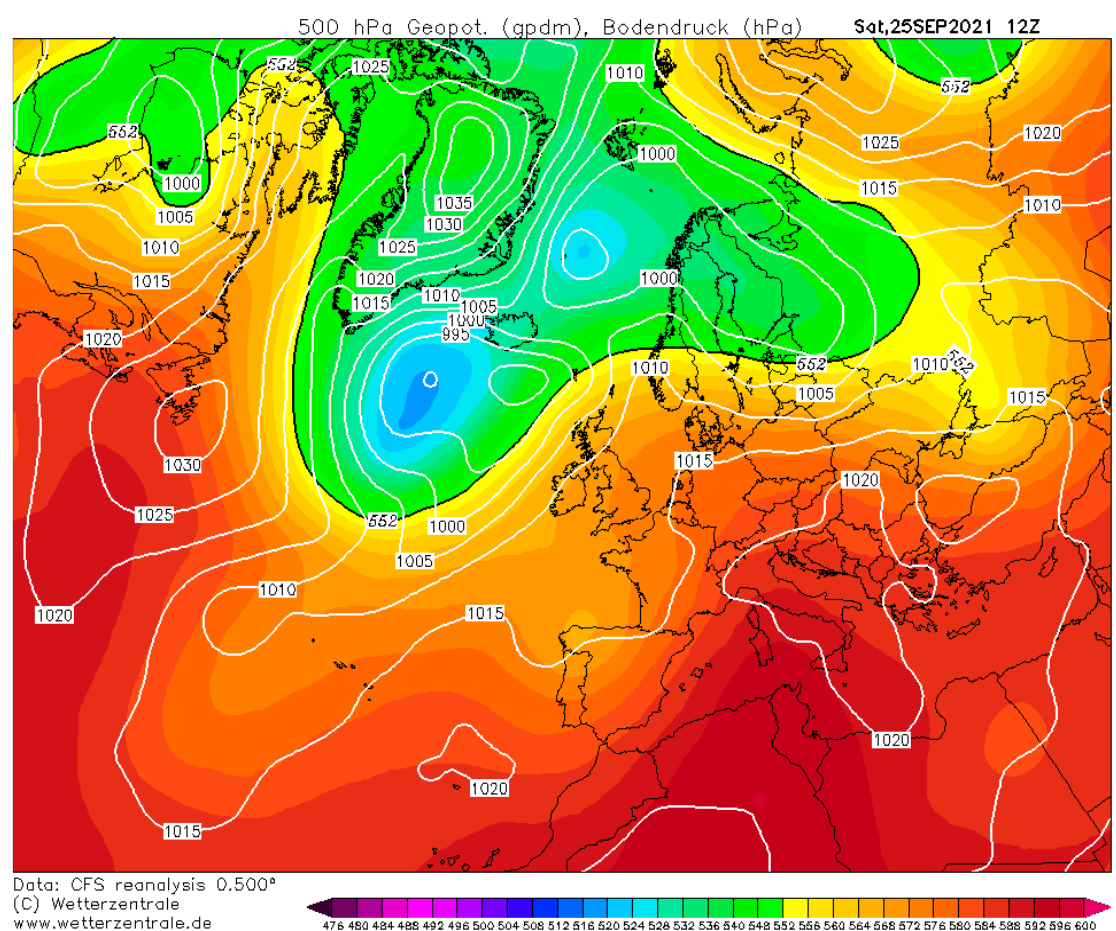
Figure 8. Geopotential height at 500 hPa (shaded color) and sea level pressure (white solid line) fields at 12:00 UTC of Saturday, 25 September 2021. Fields were retrieved from Climate Forecast System Reanalysis of National Centers for Environmental Prediction and are expressed in geopotential decameters and in hPa, respectively. Image is courtesy of www.wetterzentrale.de (last access on 18 March 2022).